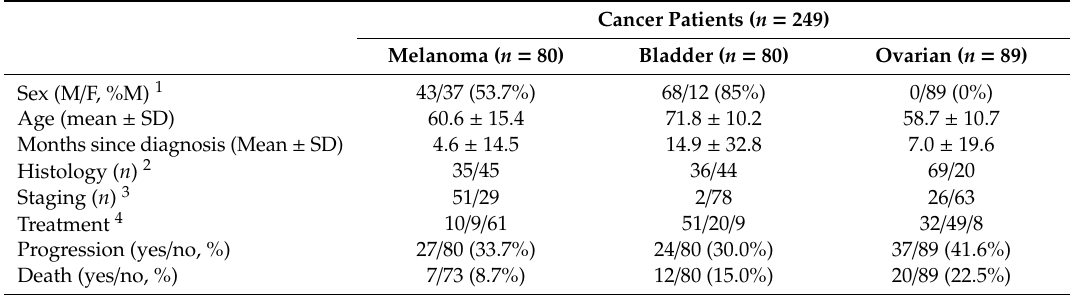
Table 1. Demographic and clinical characteristics of patients and